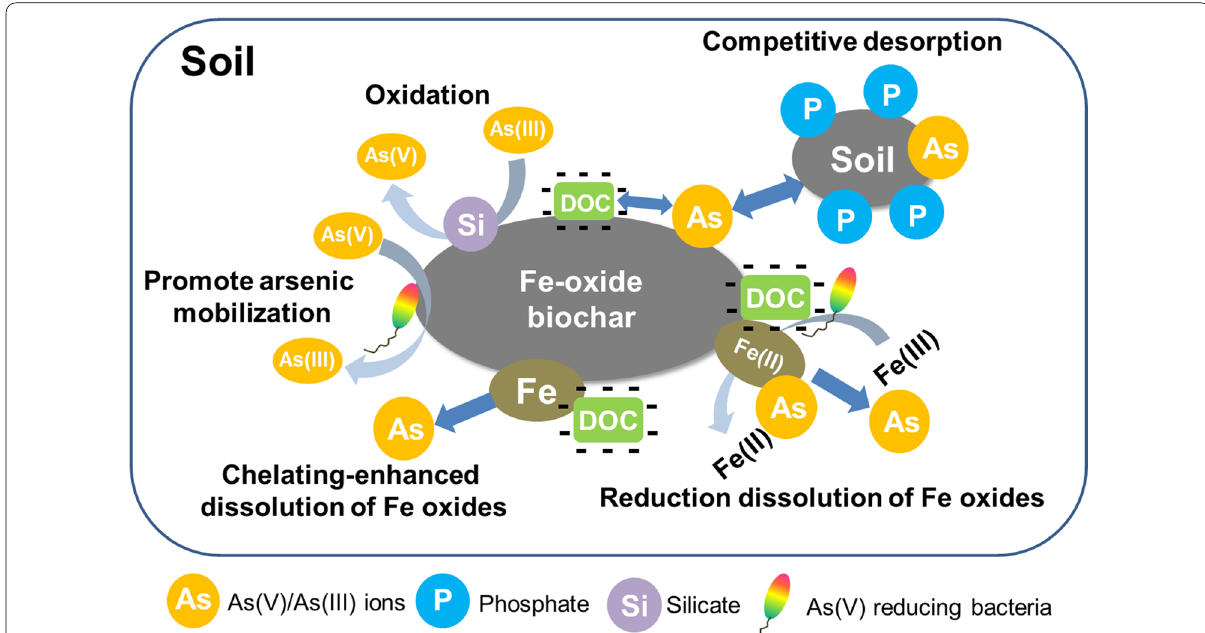
Fig. 2 Factors influencing arsenic removal in soil by iron oxide biochar [dissolved organic carbon (DOC), phosphate, silicate, and microbial